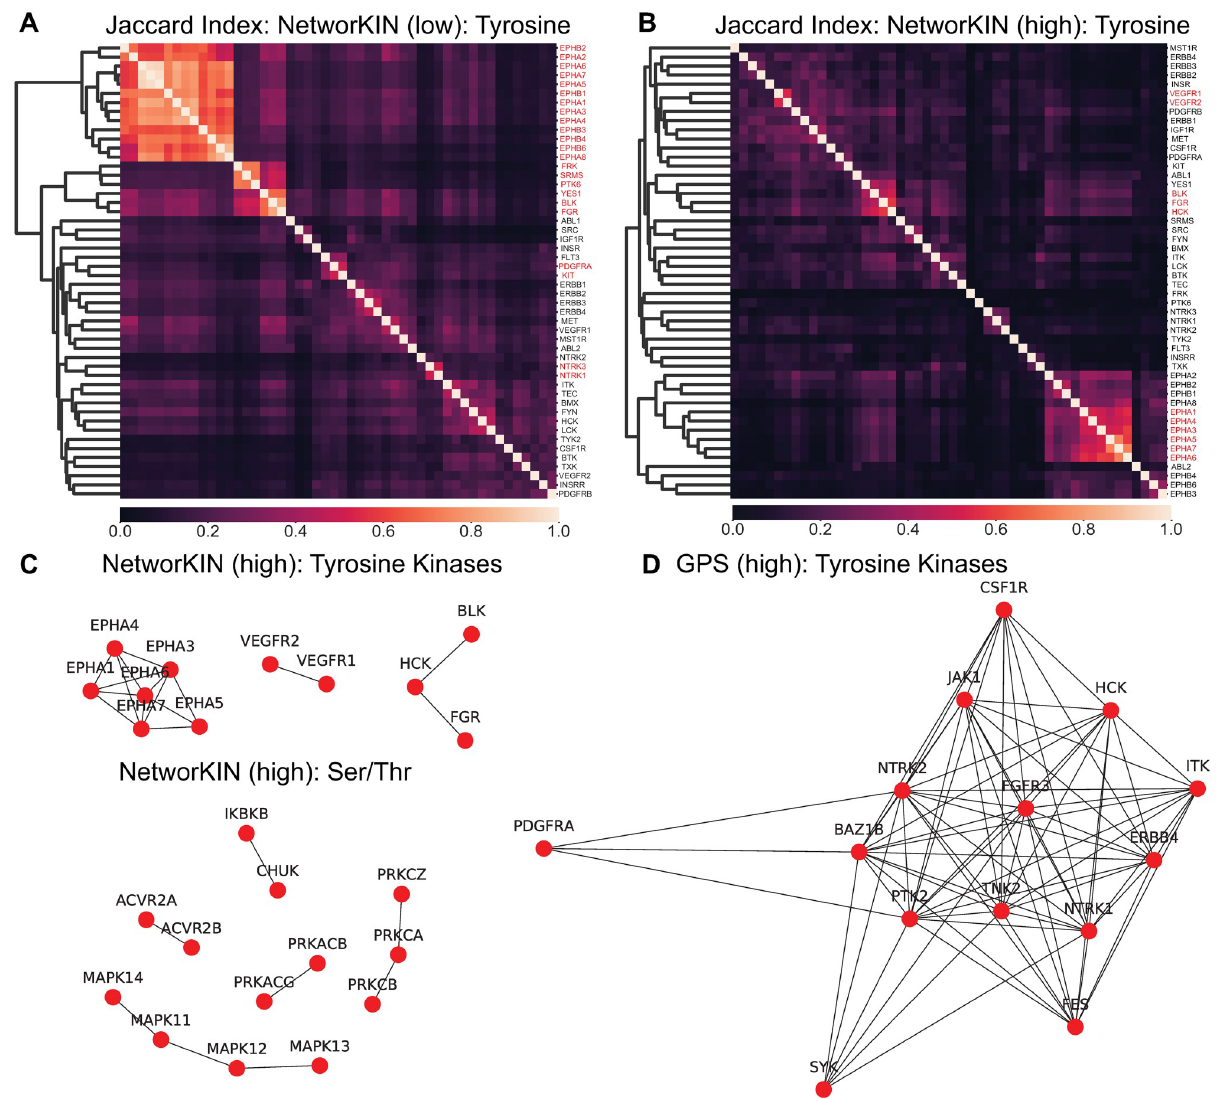
Fig 4. Within-algorithm kinase similarity. Jaccard index matrices for NetworKIN predictions at A: low and B: high stringency. The symmetric matrix was sorted hierarchically and kinase names are highlighted in red text if their Jaccard index meets a minimum of 0.001 p-value significance (a value of 0.49 or greater). Those relationships that exceed significant Jaccard index values are shown in network diagrams C: NetworKIN tyrosine and serine/ threonine kinases under high stringency and D: GPS tyrosine kinase networks (serine/threonine are large and available in S1 Fig). A spring layout was used on the weighted graph, so the closer the nodes the larger the Jaccard index. These graphs show all significant overlapping kinases in the given kinase network.